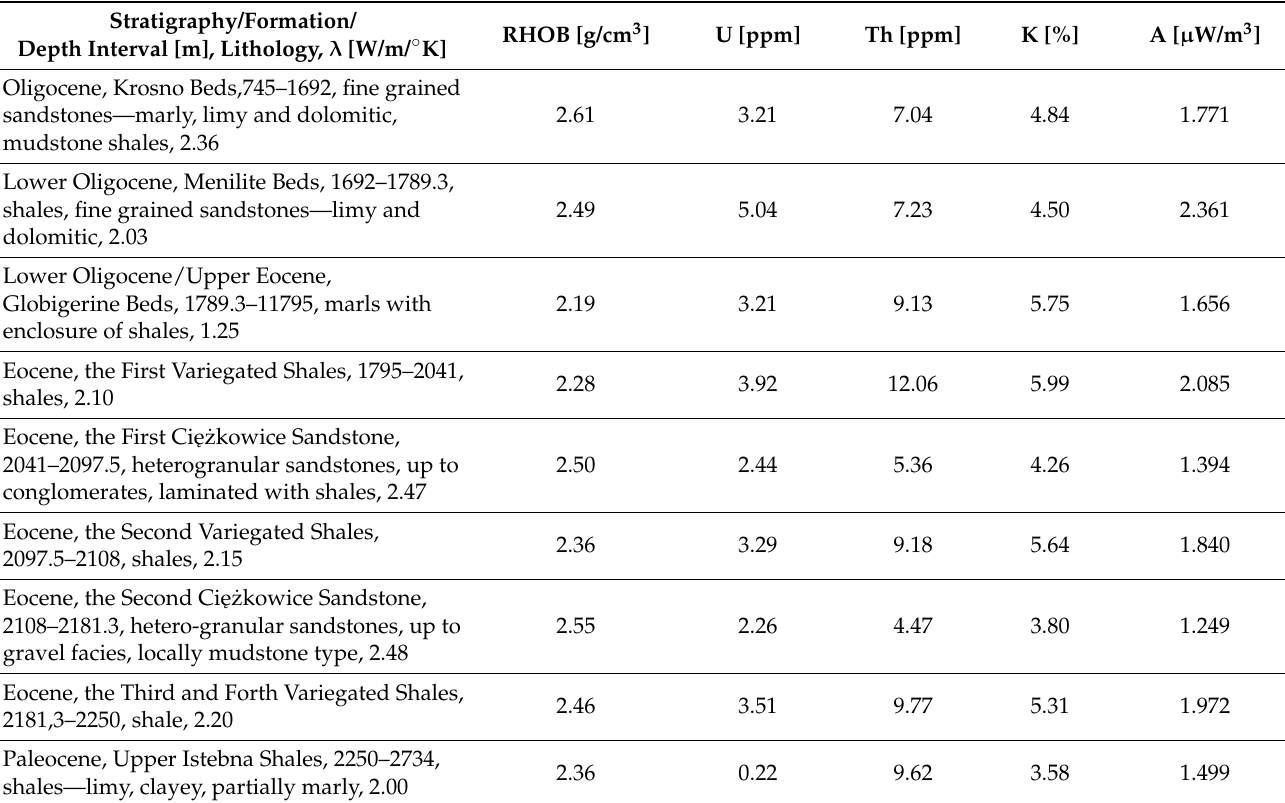
Table 6. Simple statistics of the bulk density, spectral gamma ray, SGR data and radiogenic heat in the selected formations in S-1 borehole (the Carpathians), stratigraphy and adopted thermal conductivity.